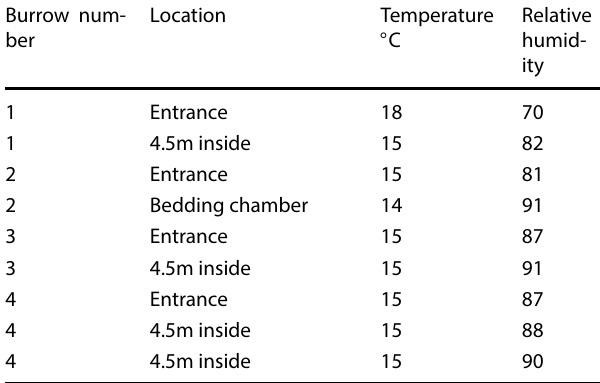
Table 6 Environmental sensing